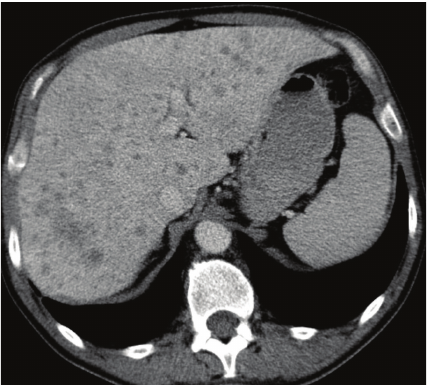
Figure 1: Thoracic X-ray: multiple pulmonary nodules are identi- fied, with upper lobe predominance. Note that some nodules show cavitation.